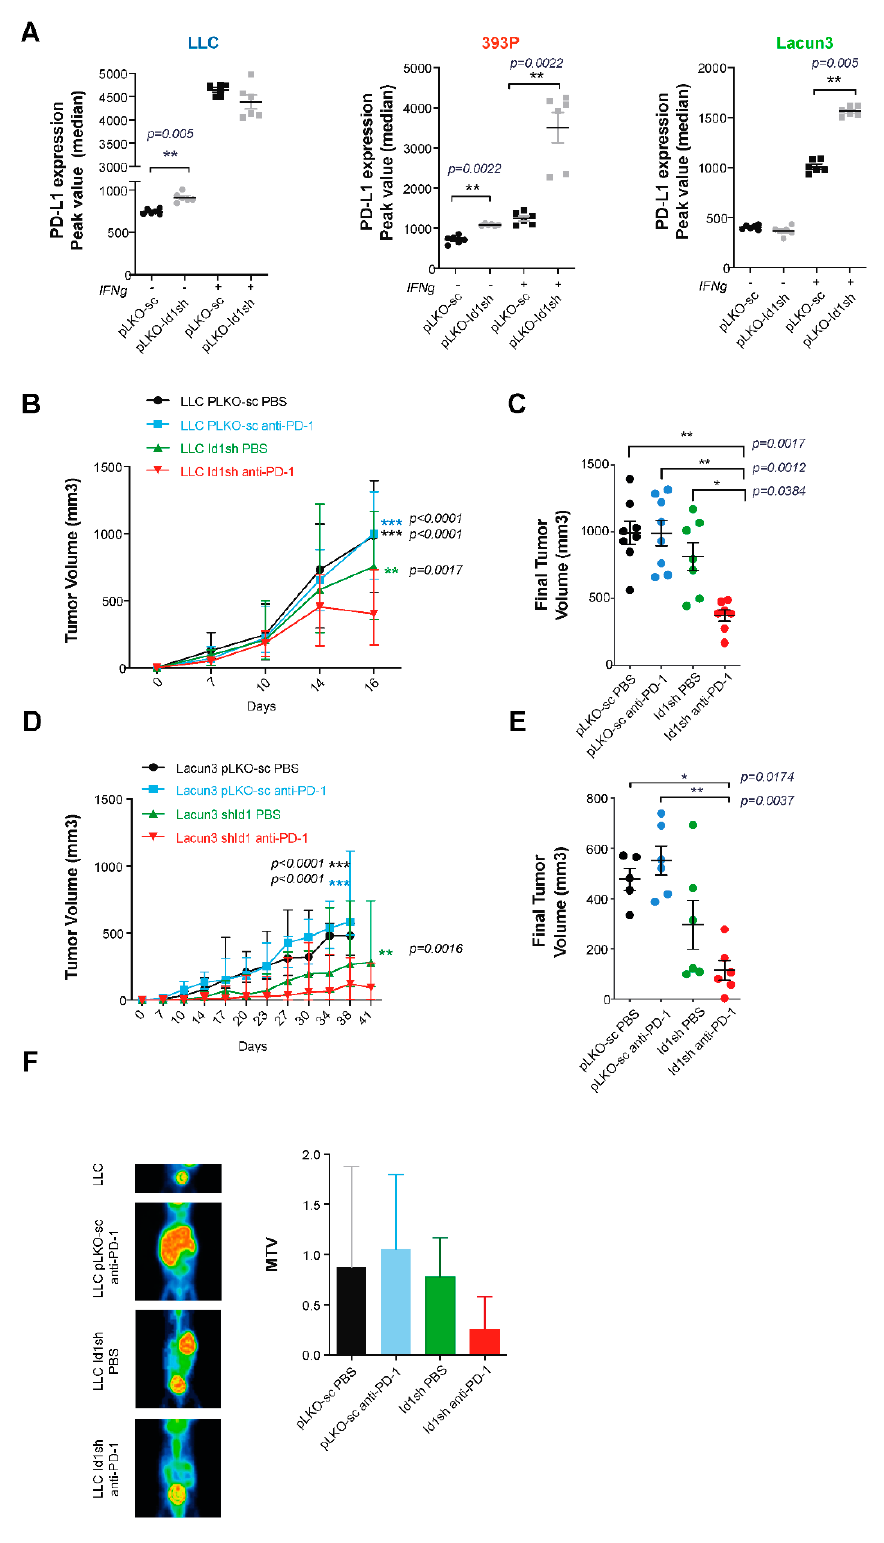
Figure 2. Silencing Id1 gene in murine LUAD cell lines induce PD-L1 expression in vitro and potentiates the antitumor activity of PD-1 blockade in a mouse model. ( A ) Flow cytometry analysis showed a statistically significant increase in PD-L1 expression when LLC, 393P and Lacun3 tumor cells had Id1 inhibited, in some cases after exposure to IFN- γ for 24 hours (Median of peak value: LLC -IFN- γ : pLKO-sc 737 [717–778], Id1 sh 895 [875.3–953.5], p = 0.005); 393P -IFN- γ : pLKO-sc 729 [624.8– 791.3], Id1 sh 1076 [1059–1115], p = 0.0022; 393P +IFN- γ : pLKO-sc 1252 [1087–1394], Id1 sh 3990 [2336 – 4184], p = 0.0022; Lacun3 +IFN- γ : pLKO-sc 989 [962.5–1085], Id1 sh 1556 [1523–1617], p = 0.005). Results